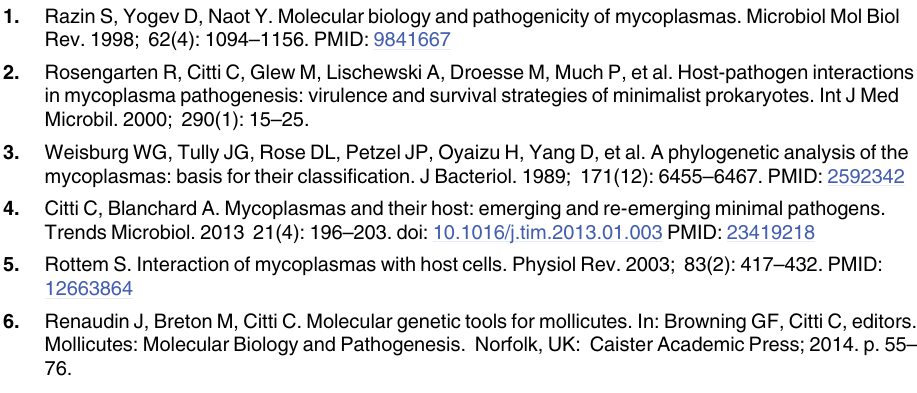
S1 Fig. Immunofluorescence staining showing the early stages of chromatin condensation in M . agalactiae -infectedHeLa cells. S2 Fig. Western blot analysis of caspase-3cleavage in M . agalactiae- infectedHeLa